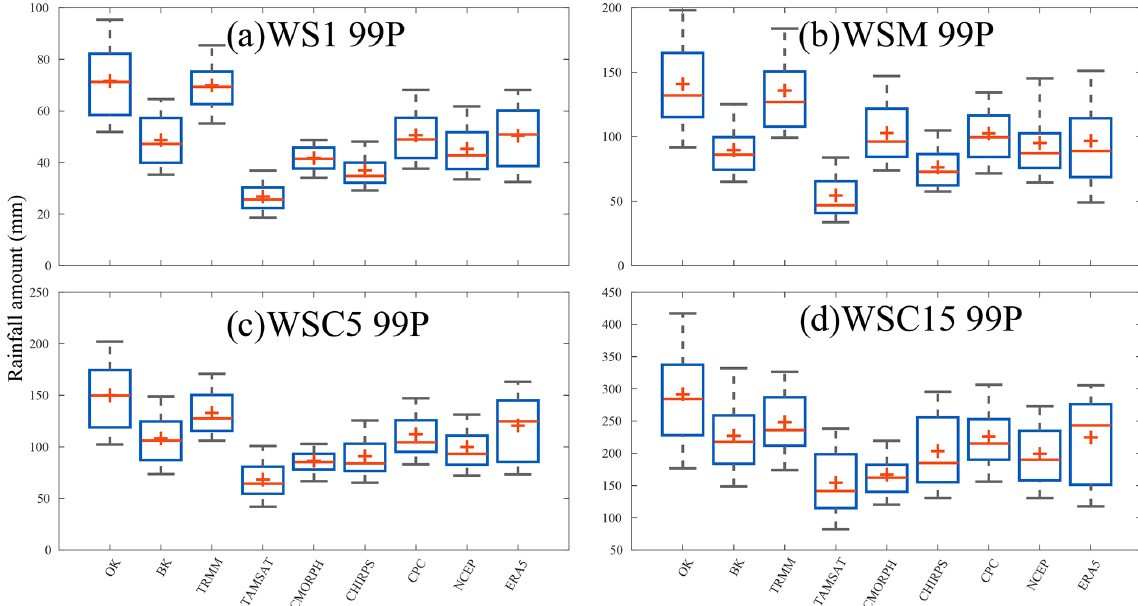
Figure 10. Box plots of amounts from all grids points from wet spells WS1, WSM, WSC5, and WSC15 (99th) per year, collected from all grid points for the nine gridded datasets used (TRMM, TAMSAT, CMORPH, CHIRPS, CPC, NCEP, ERA5, BK, and OK). The minus sign ( − ) represents the median value, the plus sign ( + ) represents the mean value, the bottom and top edges of the box represent the 25th and 75th percentile values, respectively, and the whiskers represent the extreme values (5% and 95%). The average number of wet spells is computed for the overlap period (1998–2010). Details on the datasets and wet spells are provided in Tables 1 and 3,